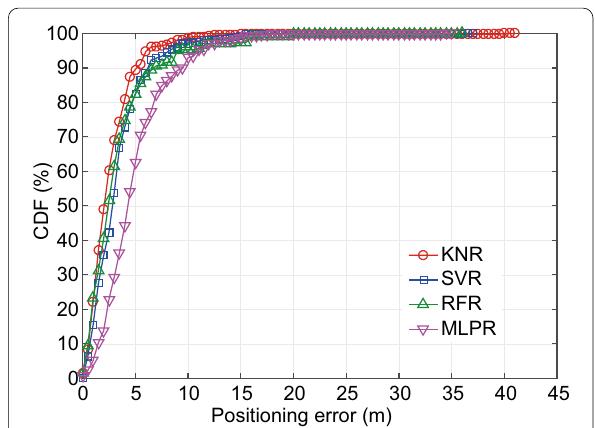
Fig. 7 Positioning errors of regression methods based on the training sheet after floor discrimination in the CETC331